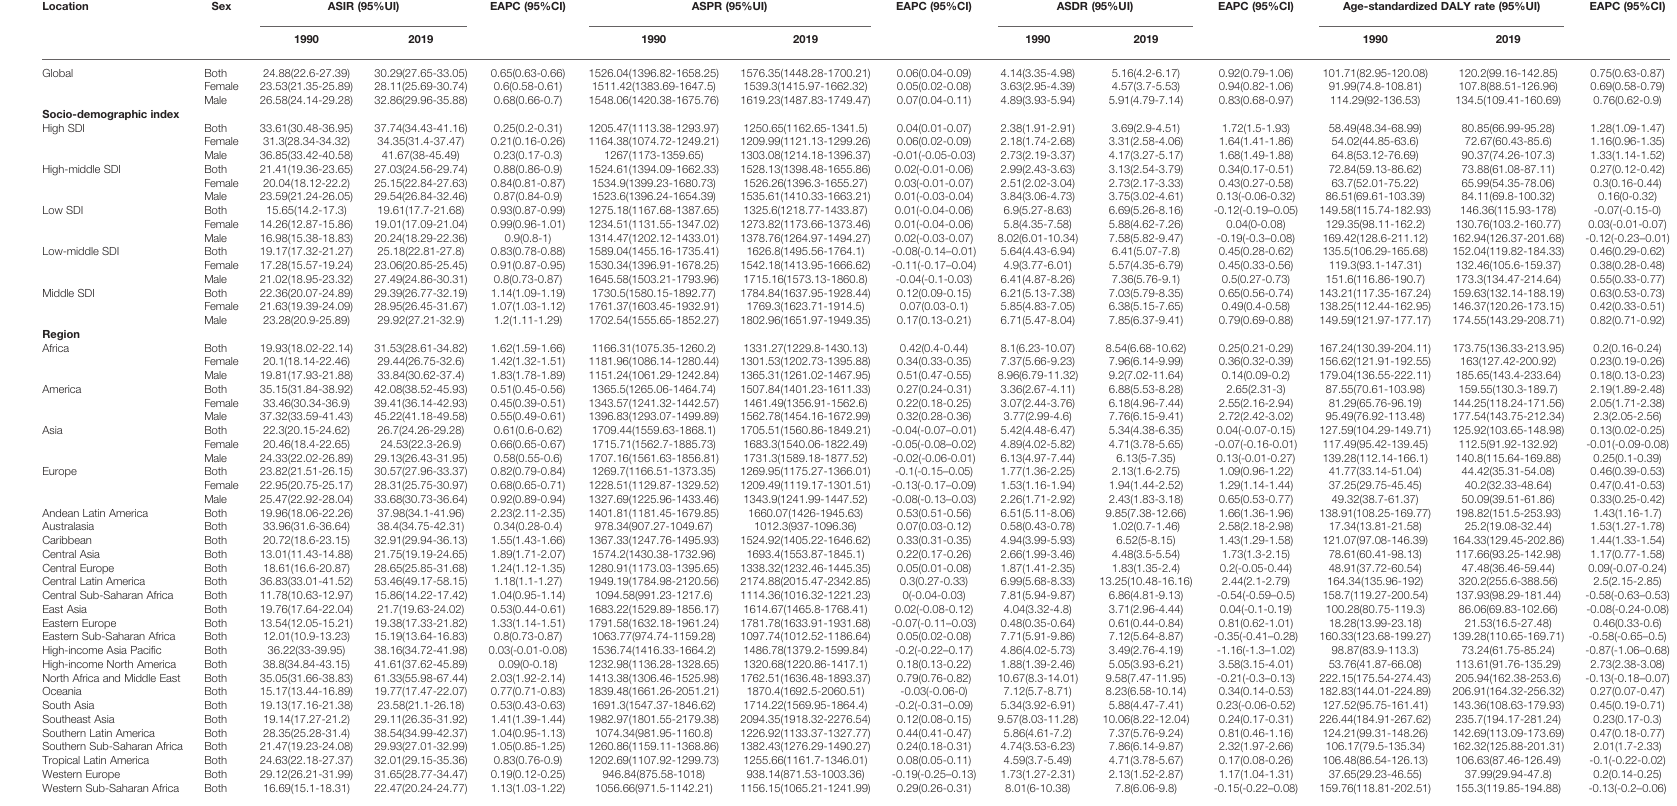
TABLE 2 | The age-standardized rates and variation trends of diabetes mellitus type 2 – related chronic kidney disease.